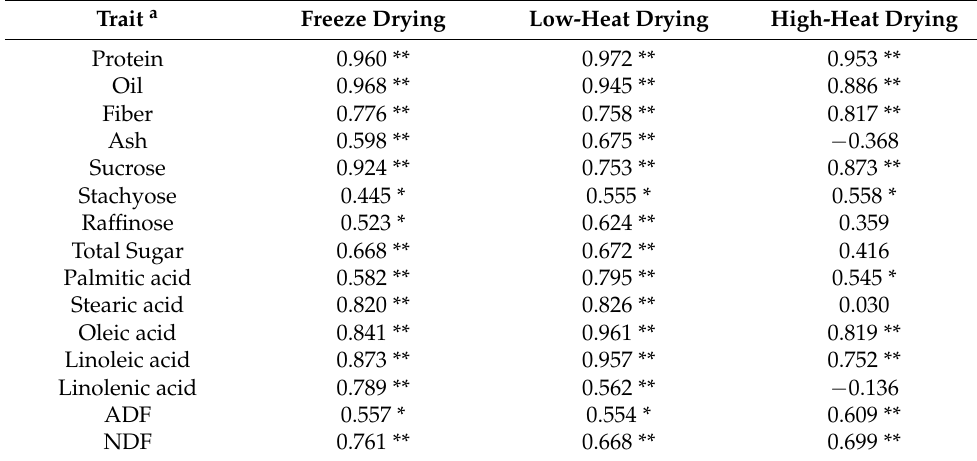
Table 5. Correlation coefficients between ground and whole seed